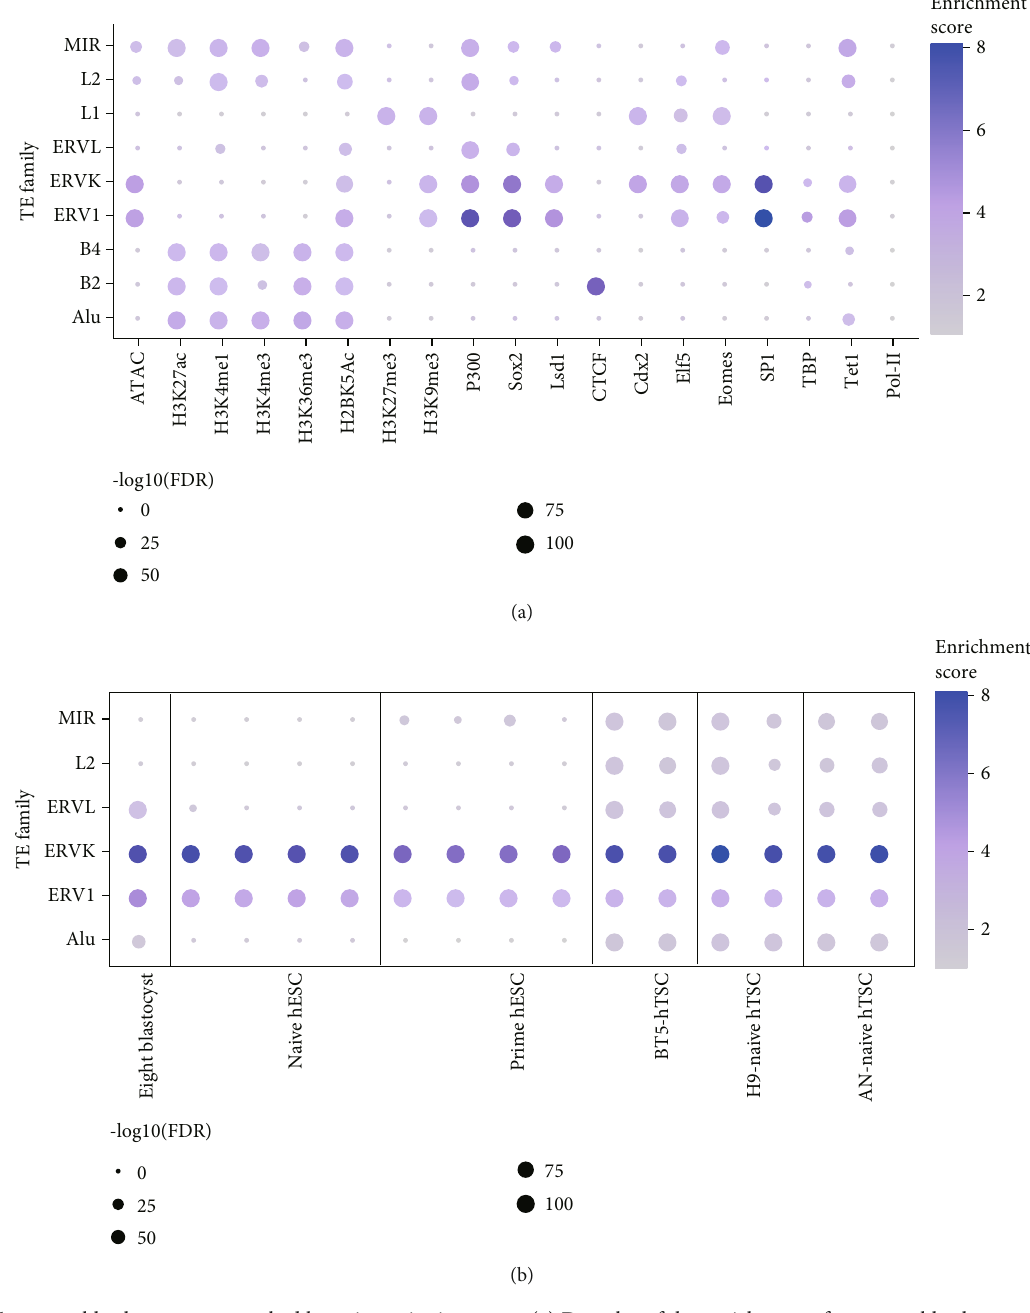
Figure 3: Transposable elements are marked by epigenetic signatures. (a) Dot-plot of the enrichment of transposable elements families in 8 chromatin marks and 11 bound factors in mouse TSCs. The size of the circle represents corrected enrichment P values. The colour indicates the enrichment score which was computed with a combination of the binomial test and hypergeometric test [89]. (b) Dot-plot of the enrichment of transposable elements families in open chromatin regions de fi ned by ATAC-seq peaks in human eight-stage blastocysts, naïve ESCs, primed ESCs, blastocyst-derived TSCs, H9-derived TSCs, and AN1 iPSC-derived TSCs. The size of the circle represents corrected enrichment P values. The colour indicates the enrichment score which was computed with a combination of the binomial test and hypergeometric test